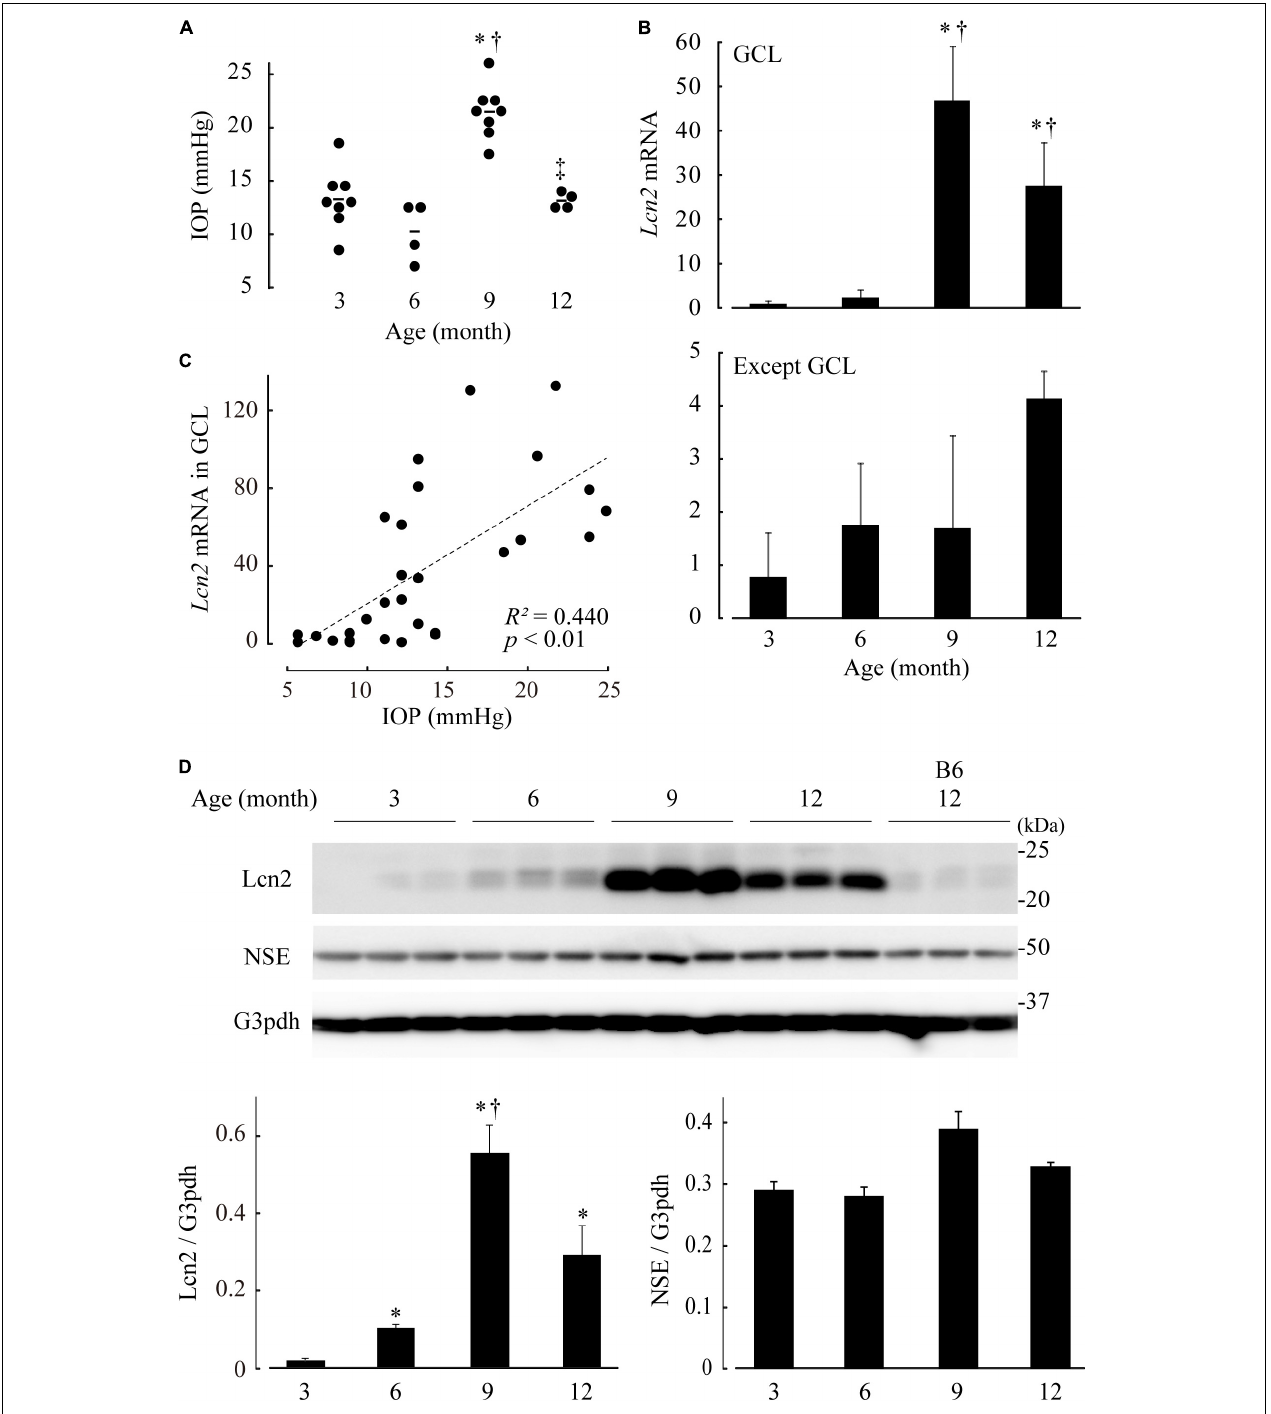
FIGURE 6 | Elevated intraocular pressure (IOP)-induced lipocalin 2 (Lcn2) upregulation in retinae of DBA/2J mice. (A) IOP of DBA/2J mice at 3, 6, 9, and 12 months of age. (B) mRNA levels of Lcn2 in dissected ganglion cell layer (GCL) (upper) and residual retinal layers (lower). Expression levels are represented as the mean ± standard error of fold changes compared to the level of the GCL at 3 months. (C) Correlation analyses between IOP and Lcn2 mRNA levels. In each graph, the dot distribution approximates a linear function (dotted lines). Correlations and statistical significance were performed using Spearman’s rank test. A straight line of best fit (dotted lines), R 2 - and p -values are shown. (D) Lcn2 protein levels in the retinae of DBA/2J mice. Retinal tissue extracts of DBA/2J mice at each age were subjected to immunoblotting for Lcn2, neuron-specific enolase (NSE) and glyceraldehyde-3-phosphate dehydrogenase (G3pdh). Retinae of C57BL/6J (B6) mice were used as an aging control. Graphs represent relative protein levels of Lcn2 and NSE compared to the G3pdh loading control. * p ≤ 0.05 vs. 3 months, † p ≤ 0.05 vs. 6 months, ‡ p ≤ 0.05 vs. 9 months.